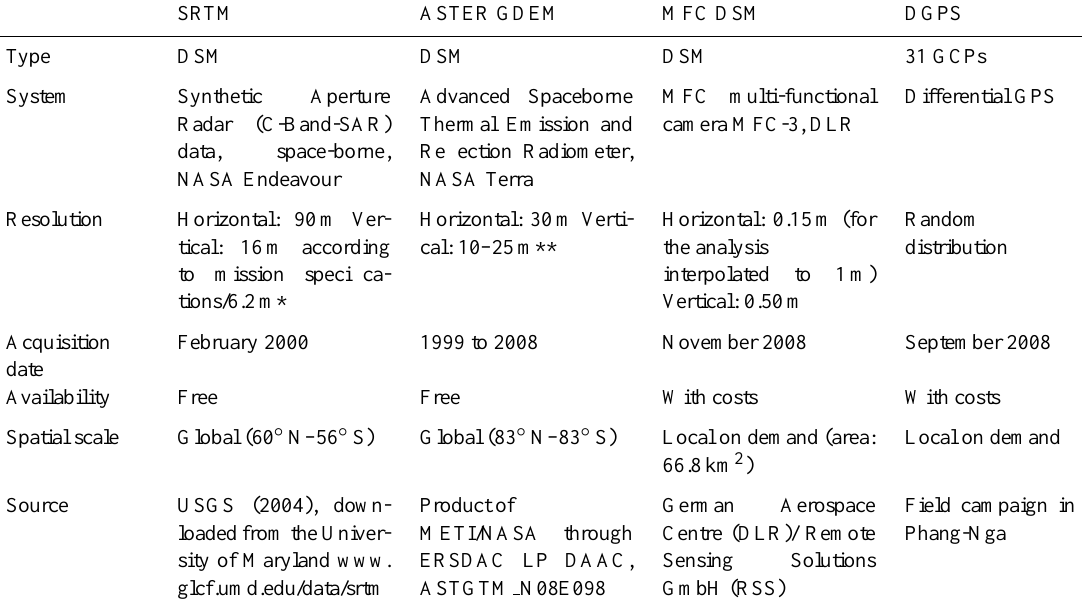
Table 1. Elevation data sets applied in the study. SRTM ASTER